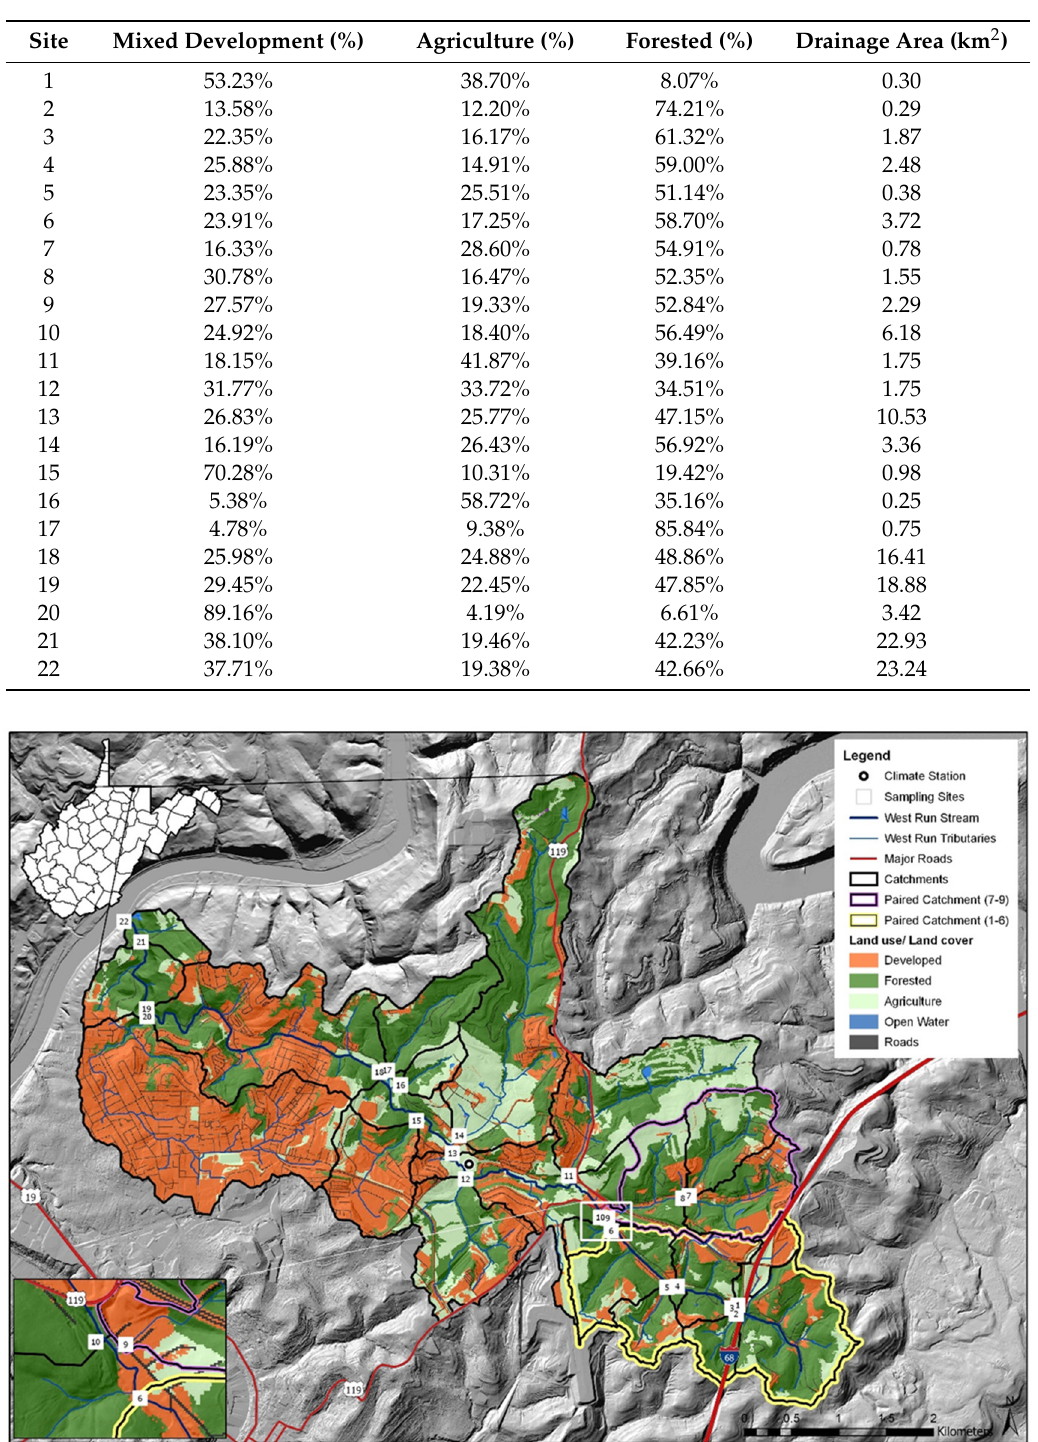
Figure 1. Monitoring / sampling locations for the current investigation, with land use / land cover, in West Run Watershed, Morgantown, West Virginia, USA.